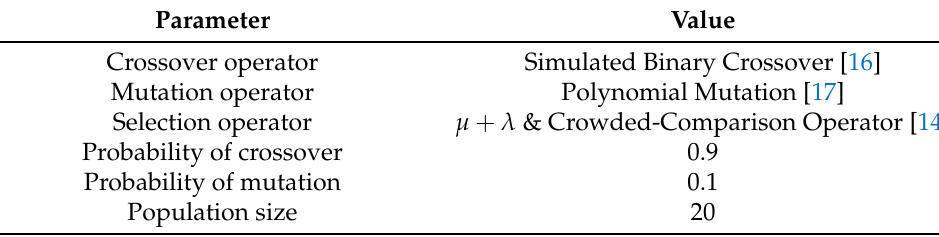
Table 1. Parameters of the Genetic Algorithm.